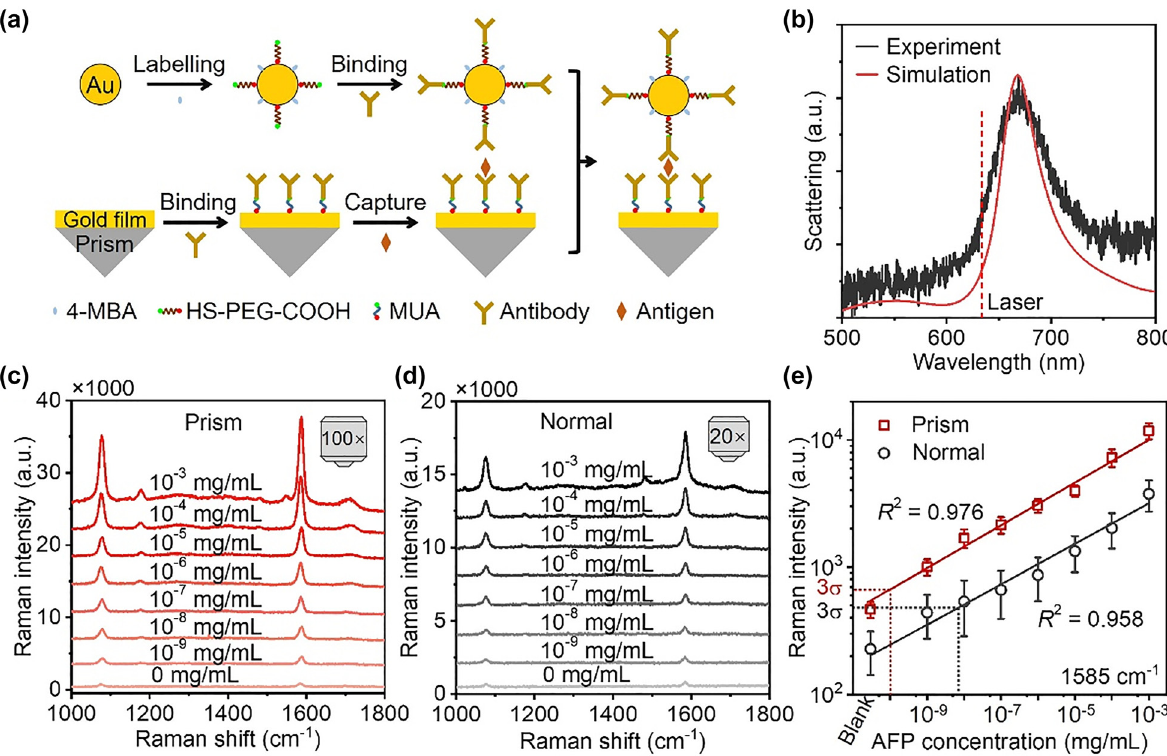
Figure 3: SERS-based immunoassay for sensitive detection of AFP. (a) Schematic of the process of preparing immune NPOM substrate. (b) Measured and simulated dark-field scattering spectra of the immune NPOM. (c, d) SERS spectra of the immune NPOM substrates with the concentration of AFP ranging from 10 − 3 to 10 − 9 mg/mL under prism (c) and normal excitation (d). (e) Plots of SERS intensities at 1585 cm − 1 as a function of the concentration of AFP. Error bars indicate the standard deviations of 50 measurements. 𝜎 represents the relative standard deviation of the SERS intensities of the blank